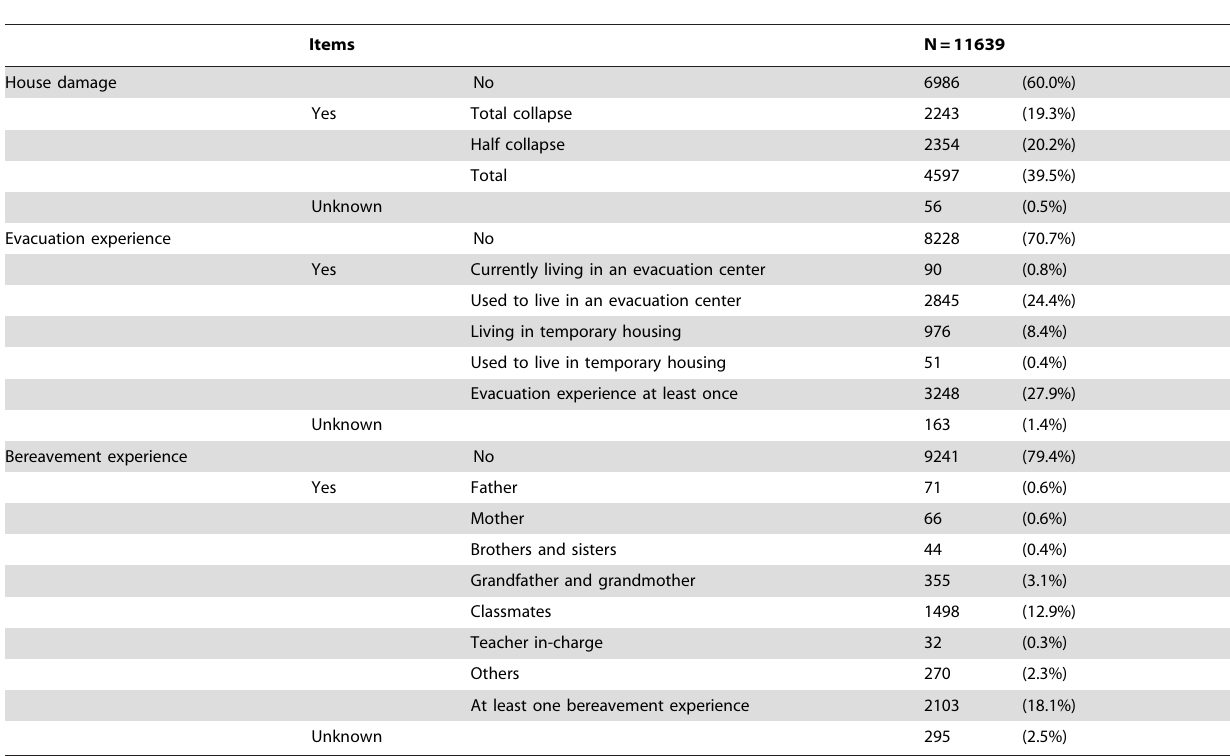
Table 1. Damage condition of children affected by the 2011 Japan Earthquake and Tsunami.